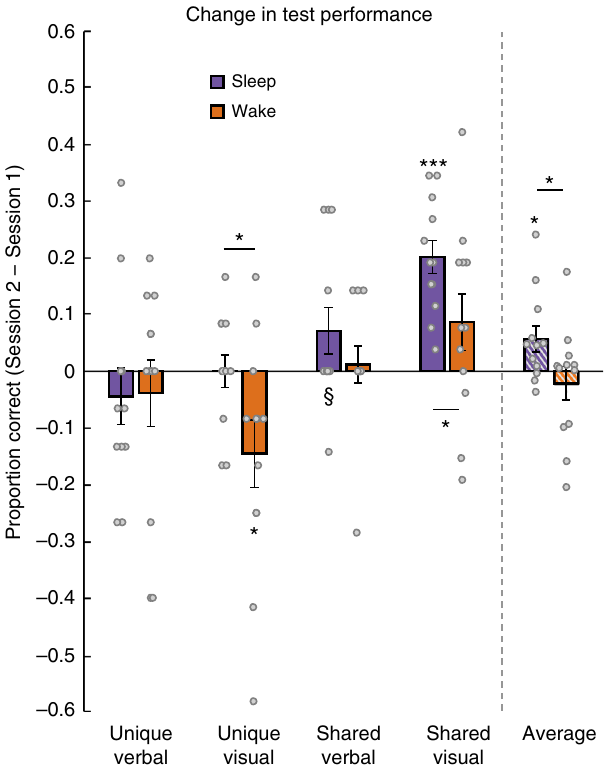
Fig. 2 Behavioral results. Change in proportion correct from the fi rst to second session for Sleep and Wake group, for different feature types and the average across feature types; § p < 0.1, * p < 0.05, *** p < 0.001, one- tailed t -test. Asterisks above horizontal lines show signi fi cant differences between conditions; asterisks without bars indicate where conditions differ from zero. Gray circles indicate performance of individual subjects.